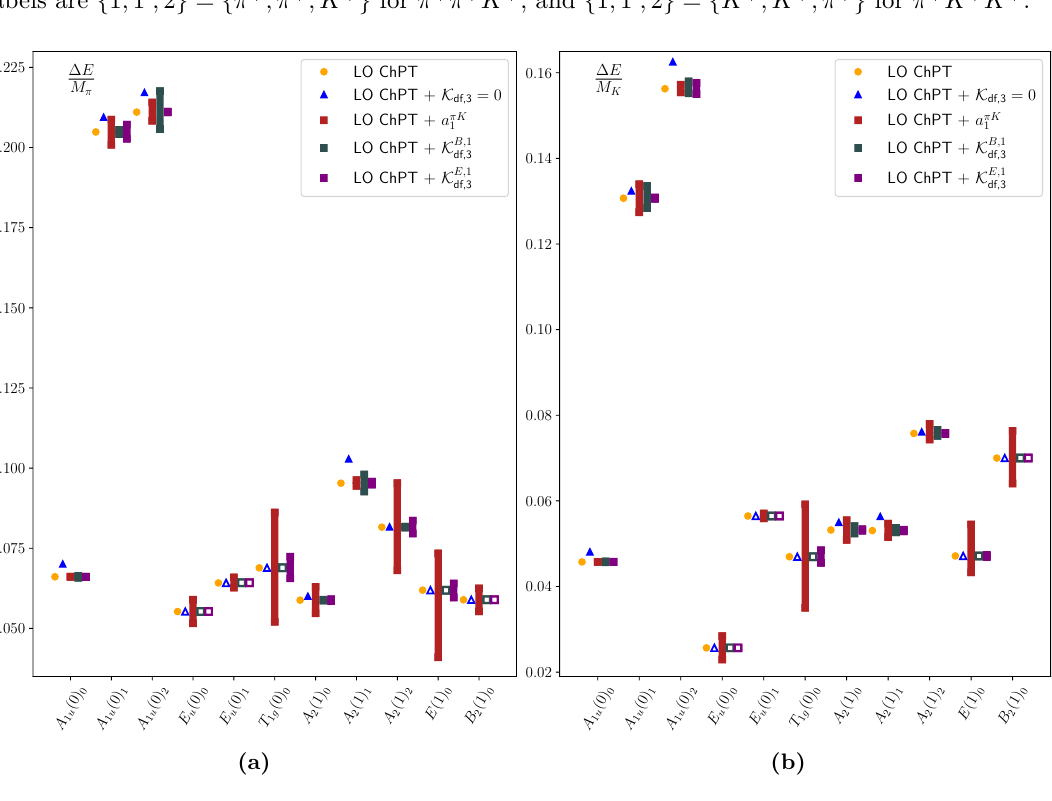
) , where d = P L/ (2 π ) describes the frame, level ref ref